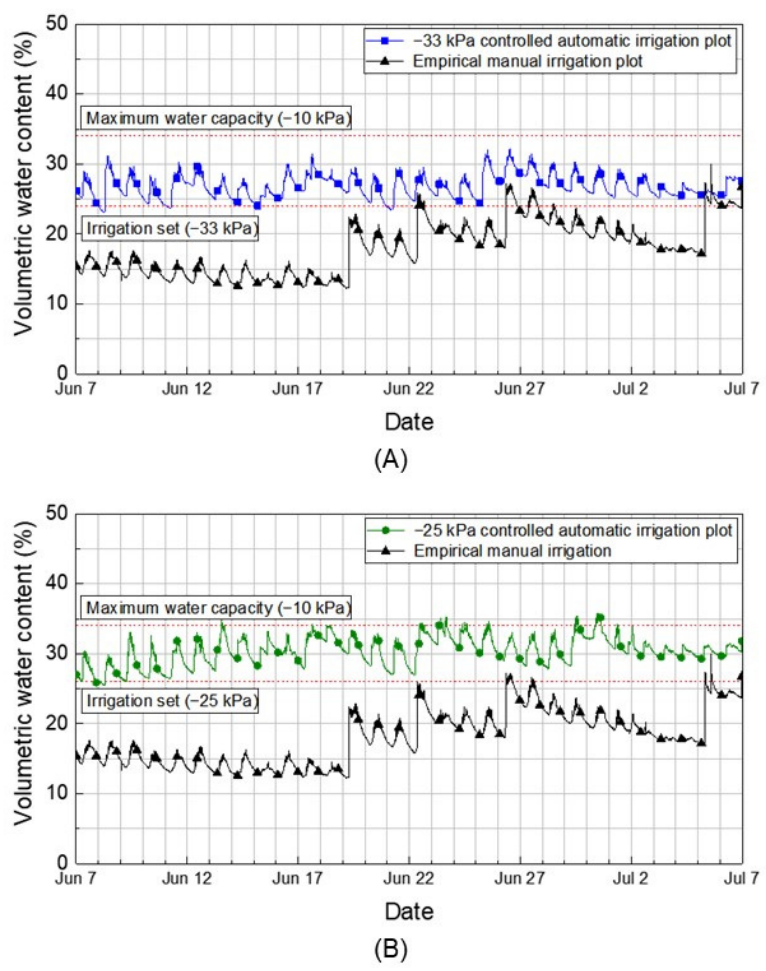
Figure 9. The results of soil moisture control in the experimental field during the first cropping season: ( A ) − 33 kPa-controlled automatic irrigation plot; ( B ) − 25 kPa-controlled automatic irrigation plot.